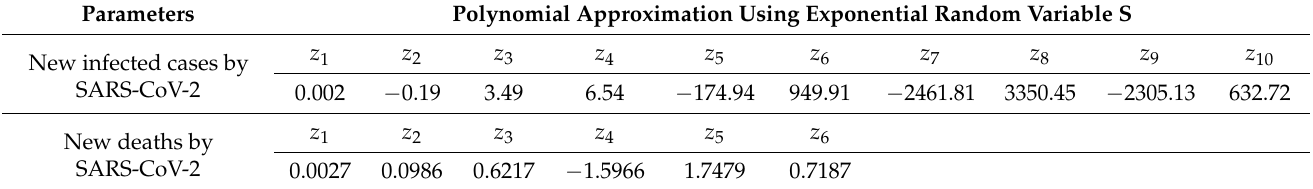
Table 8. Estimation of polynomial function of key parameters of epidemic risk using MM. Parameters